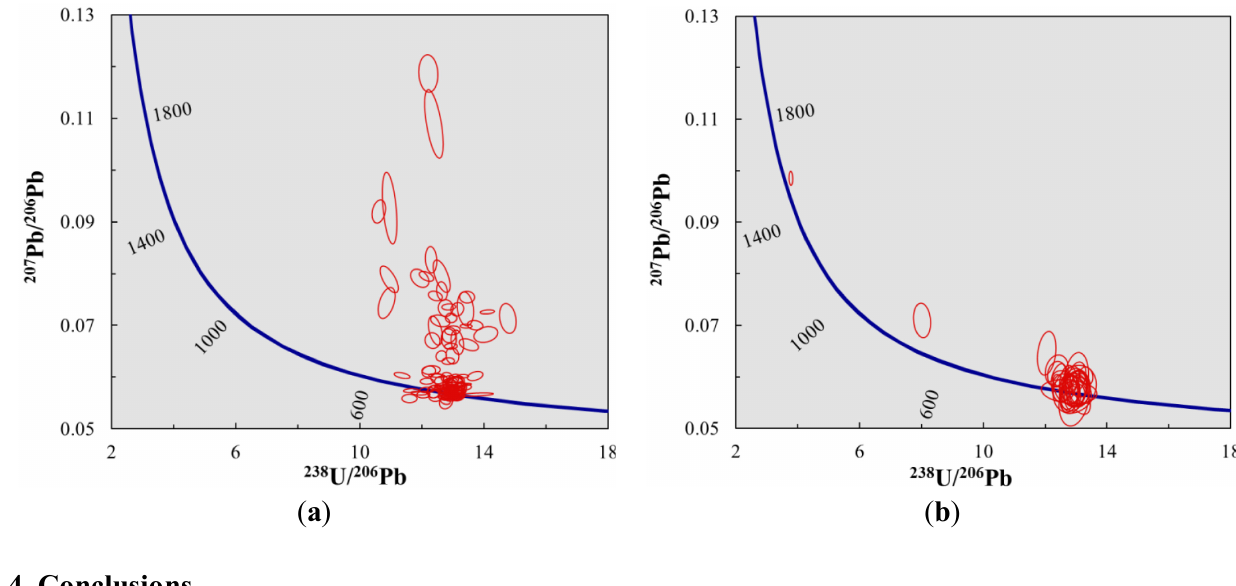
Figure 7. Tera-Wasserburg plots for sample 10/225 , error ellipses are 2σ : ( a ) untreated zircons analysed at UCSB by LA-MC-ICP-MS; and ( b ) chemically abraded zircons analysed by LA-Q-ICP-MS at